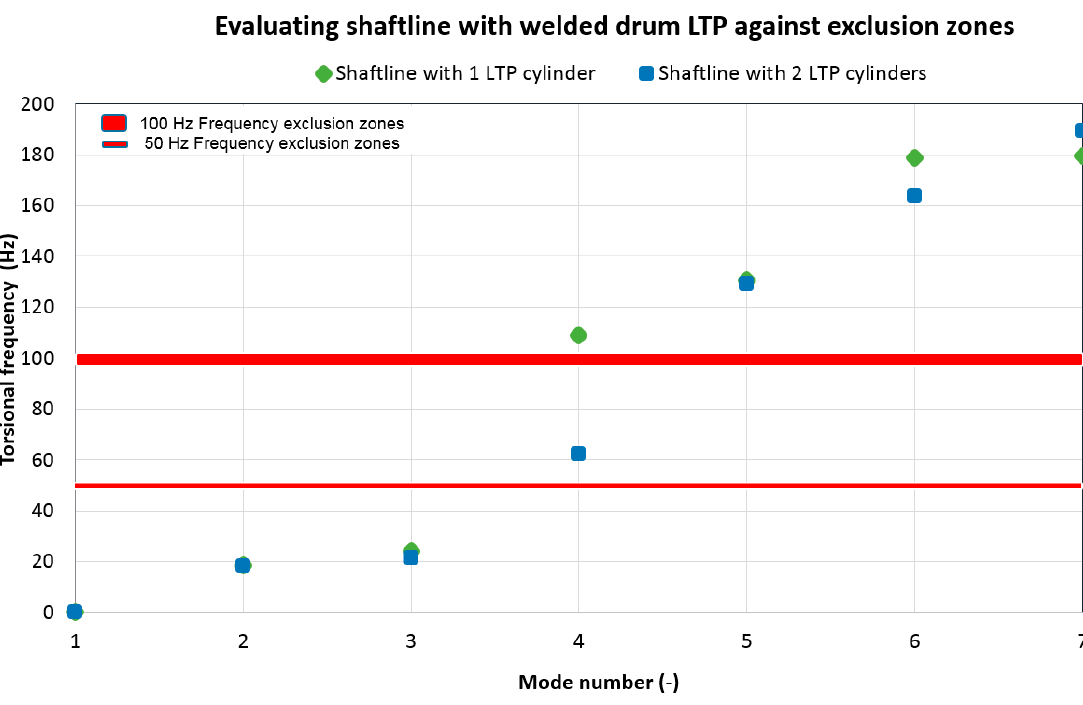
Figure 13. Evaluating monoblock LPT cylinder shaft frequency.